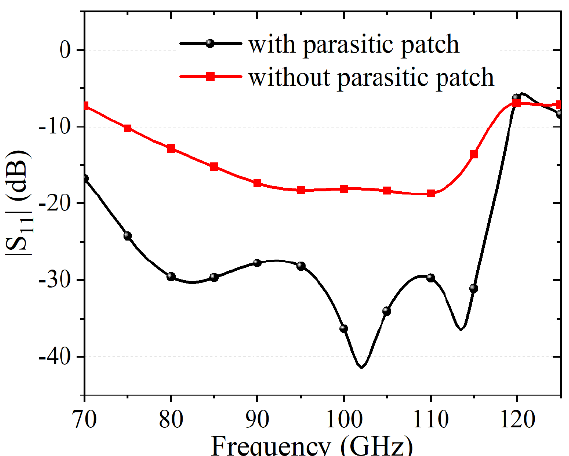
Figure 6. Simulated reflection coefficient of the proposed transition with and without parasitic patch.